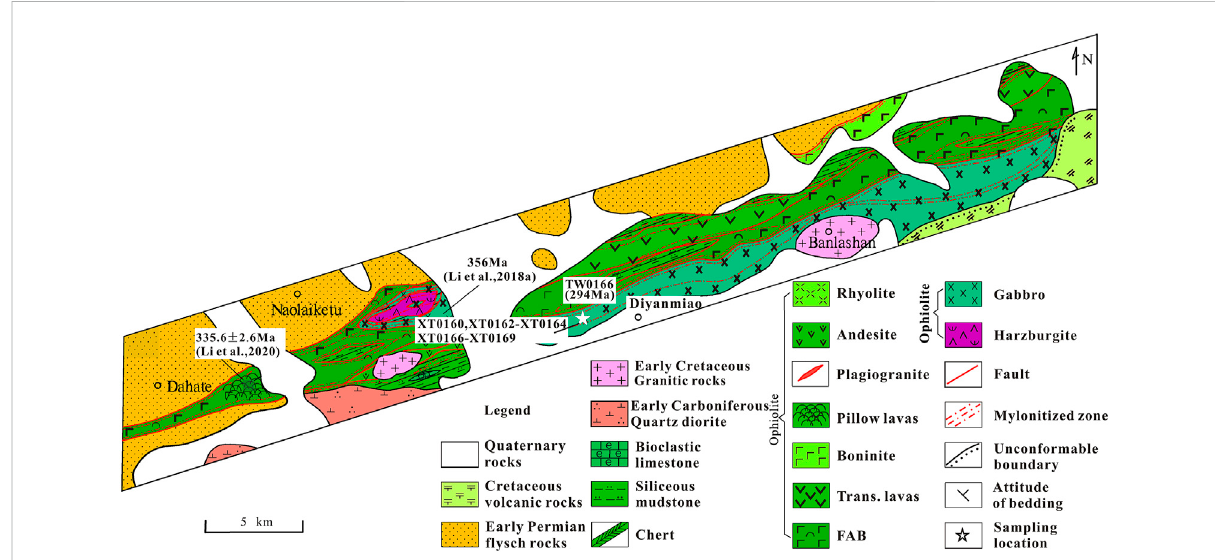
FIGURE 2 Simpli fi ed geological map of the Naolaiketu ophiolite in Diyanmiao (modi fi ed after Li et al., 2020a).